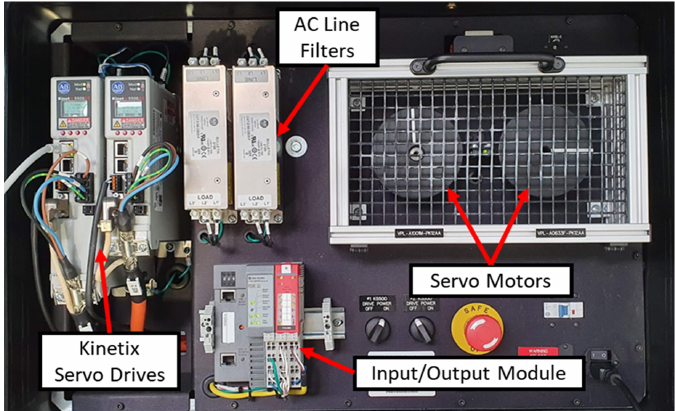
Figure 5. Rockwell Automation Training Workstation, incorporating two servo motors (only one is used in the application in this paper).